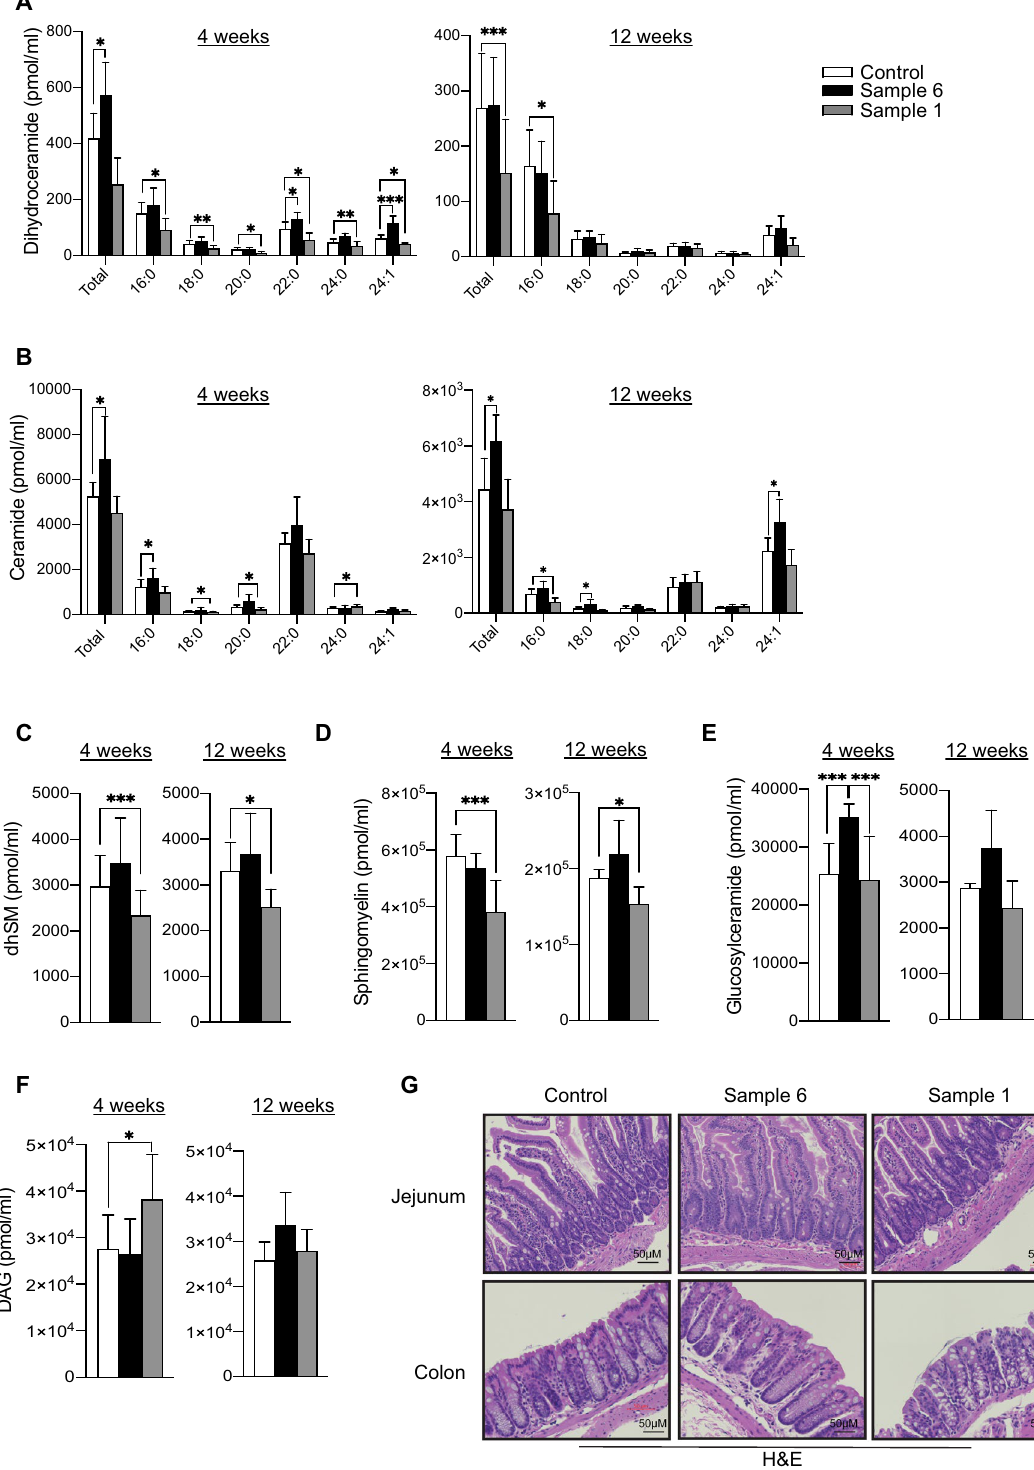
Figure 2. Treatment of mice with obesogenic diets supplemented with myriocin containing Cordyceps extracts reduces ceramide without altering intestinal morphology. Quantitative mass-spectrometry analyses of ( A ) Dihydroceramide, ( B ) Ceramide ( C ) Dihydro-sphingomyelin (dhSM), ( D ) Sphingomyelin, ( E ) Glucosylceramide and ( F ) Diacylglycerol content in serum isolated from C57Bl6/J fed high fat diets supplemented with starch (control), Sample 1 and sample 6 for 4-weeks and 12-weeks (N = 5 per group). ( G ) Following 12-weeks of dietary Cordyceps intervention small intestine was assessed histologically (H&E staining; N = 3 animals per group) and representative samples are shown. Values are expressed as mean ± SEM, *p < 0.05, **p < 0.001, ***p < 0.0001 vs